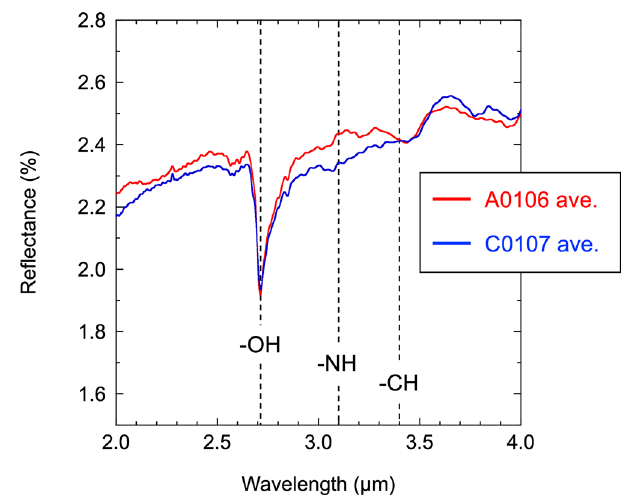
Fig. 3 | Infrared spectra of the Ryugu samples. The raw pro fi les of infrared re fl ectance spectra for Ryugu initial bulk samples (A0106 and C0107) within 2.0 – 4.0 μ m.Thedataacquisitionofthisnon-destructiveanalysisisdescribedinthe literature 2 . Signals for important functional groups (OH, NH, CH) are indicated in each band by dotted lines. The data management policy is declared in the “ Data availability ” section of this